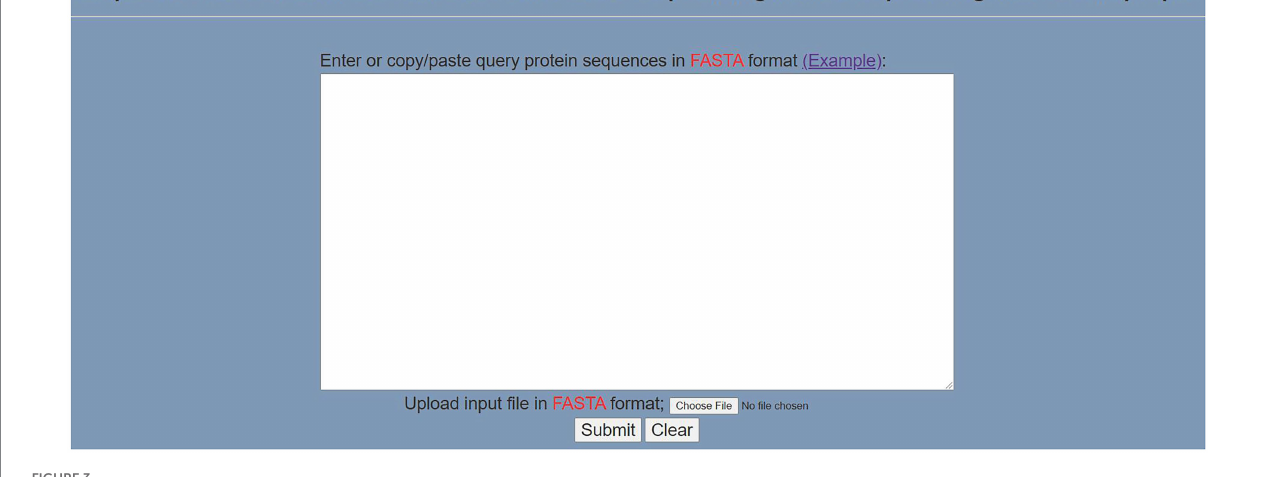
FIGURE 3 Prediction page of the web